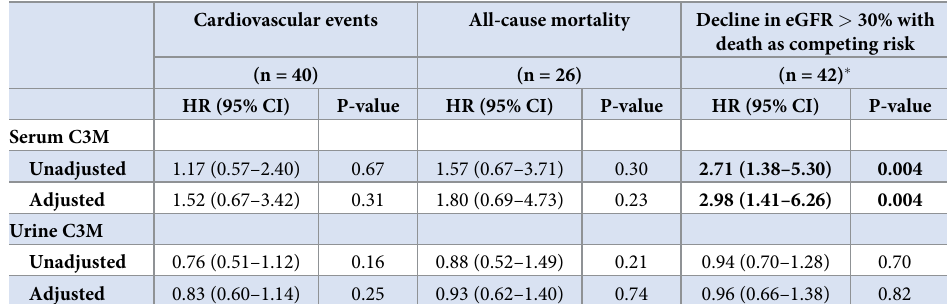
Cox regression analyses of C3M in relation to risk of fatal and nonfatal cardiovascular events, all-cause mortality and decline in eGFR > 30% in 198 participants, number of events given for each endpoint. Values are hazard ratios (HR) with 95% confidence intervals (CI) per doubling of C3M. Adjustment included sex, age, body mass index, LDL cholesterol, smoking, HbA 1c , plasma creatinine, systolic blood pressure and urinary albumin excretion rate. � Data on decline in eGFR was only available for 175 out of 198 participants (88.4%). eGFR: estimated glomerular filtration